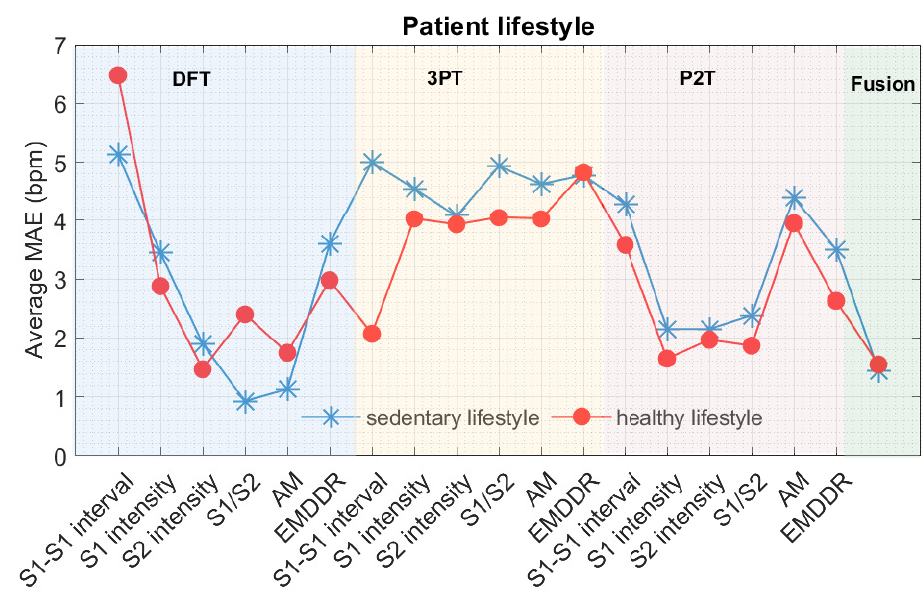
Figure 11. Comparison of MAE for subjects that followed a healthy or a sedentary